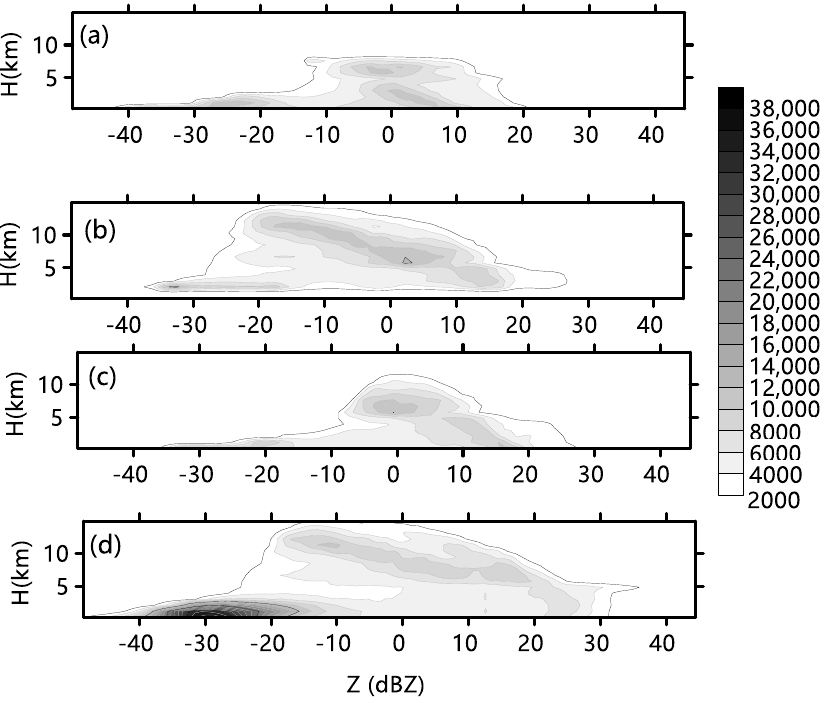
Figure 9. The numbers of occurrences of reflectivity for ( a ) CR1; ( b ) CR2; ( c ) CR3 and ( d )